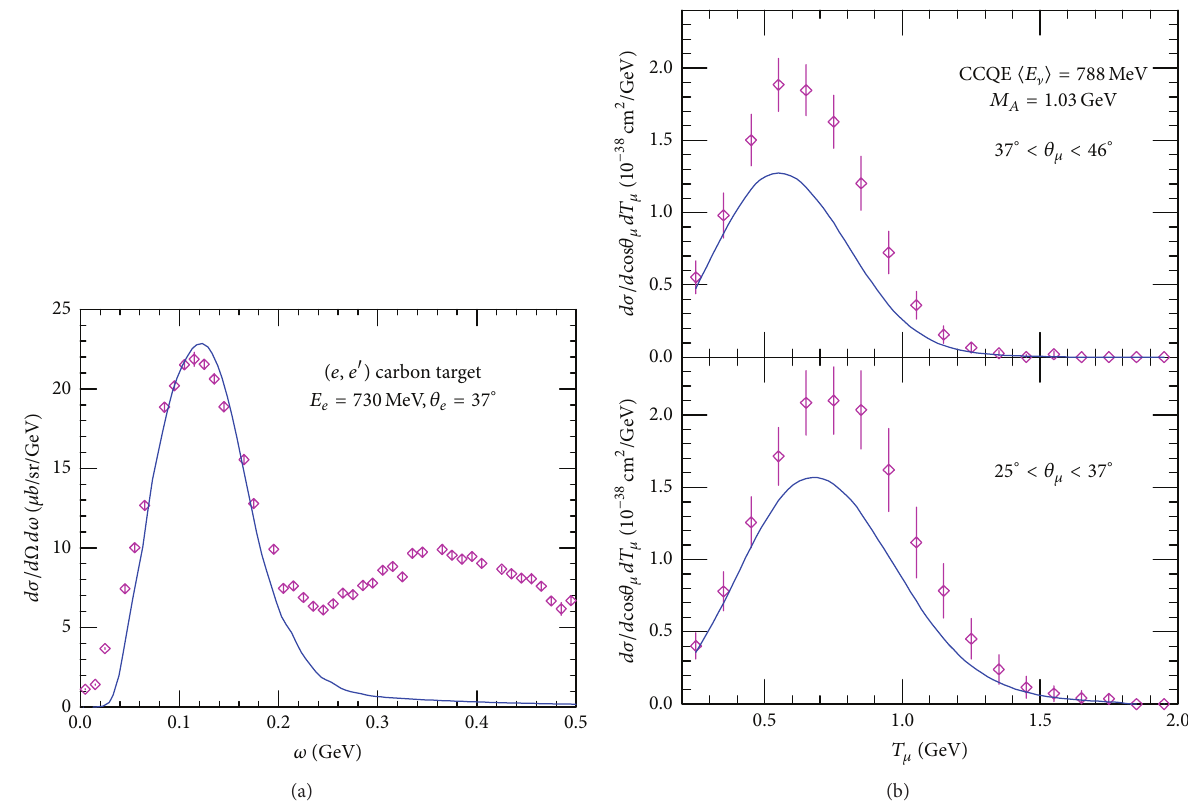
Figure 4: (a) Inclusive electron-carbon cross-section at beam energy 𝐸 𝑒 = 730 MeV and electron scattering angle 𝜃 𝑒 = 37 ∘ , plotted as a function of the energy loss 𝜔 . The data points are taken from [3]. (b) Flux averaged double differential CCQE cross-section measured by the MiniBooNE collaboration [5], shown as a function of the kinetic energy of the outgoing muon. The upper and lower panels correspond to different values of the muon scattering angle. Theoretical results have been obtained using the same spectral functions and vector form factors employed in the calculation of the electron scattering cross-section of the left panel, and a dipole parameterization of the axial form factor with 𝑀 𝐴 = 1.03